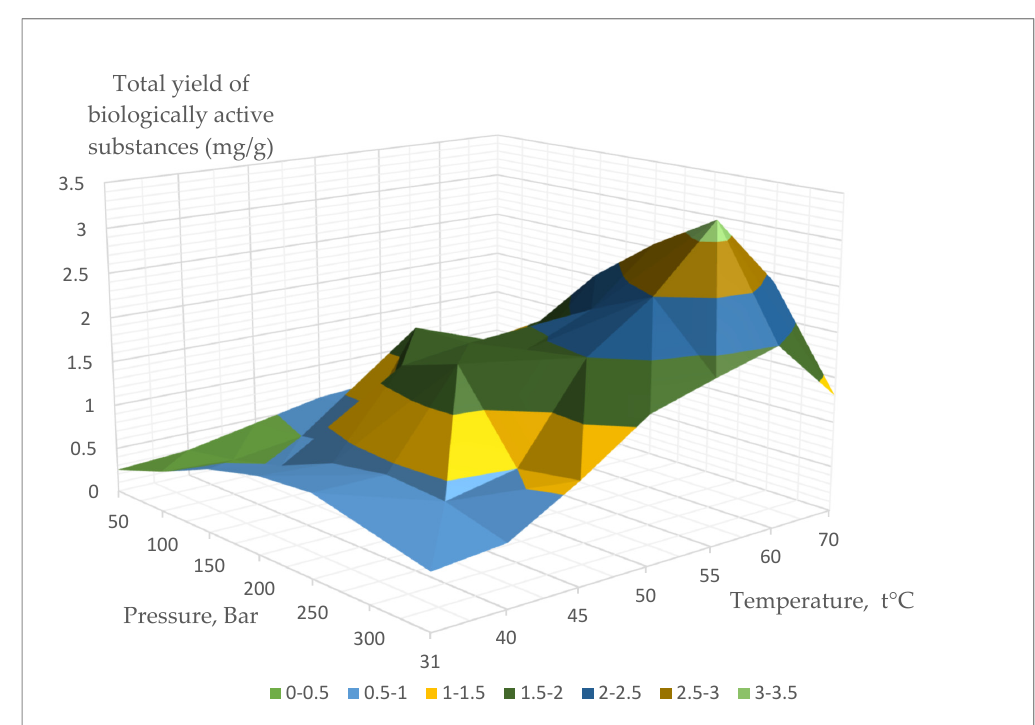
Figure 3. 3D–graph data of supercritical CO 2 -extraction. Total yield of biologically active substances from extracts of Z. marina (fresh seagrass ejection on the surf edge).